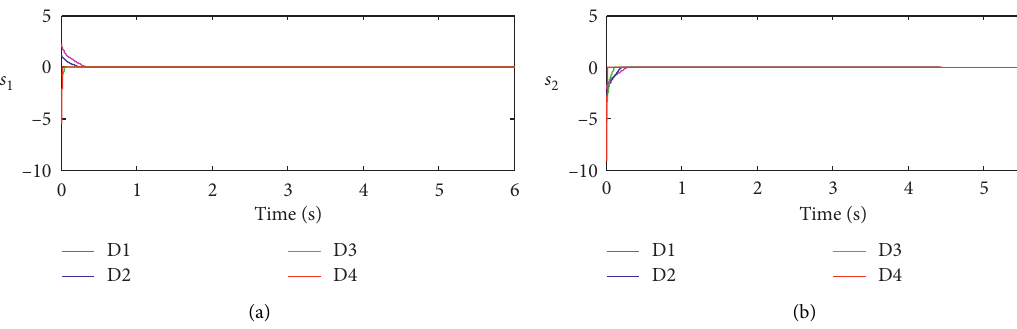
Figure 7: Sliding surfaces versus time with different desired